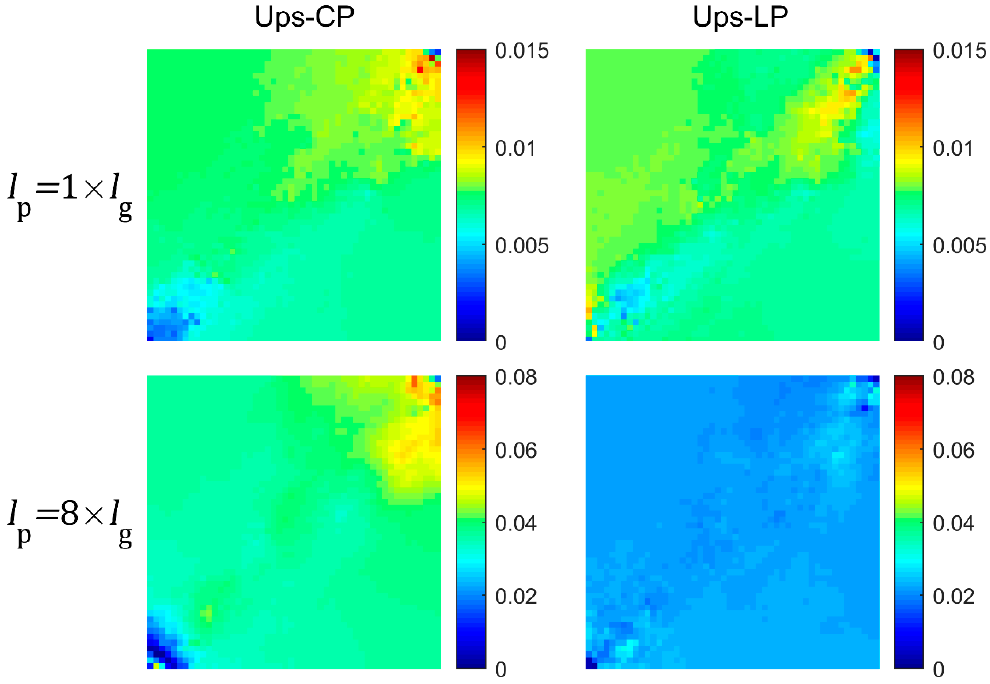
Figure 7. Relative error of pressure solutions for the Ups-CP ( first column ) and Ups-LP ( second column ) models when the partition is l p = l g ( first row ) and l p = 8 × l g ( second row ).